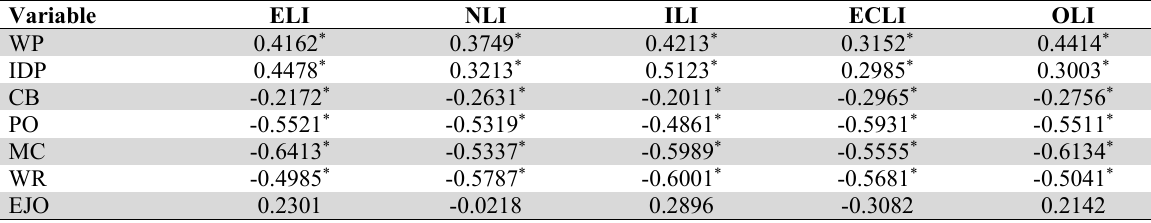
Relational Analysis between Management Factors and Dimensions of Loyalty Imbalance” Variable